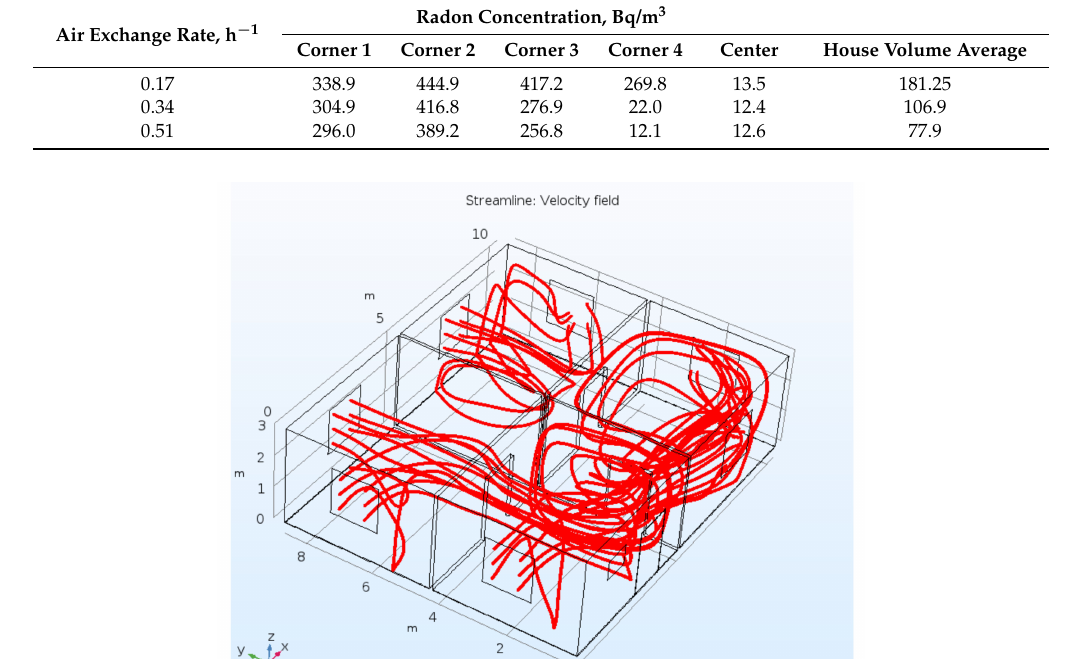
Table 2. Radon concentration at the selected points in the windward corner room at z = 1.5 m.